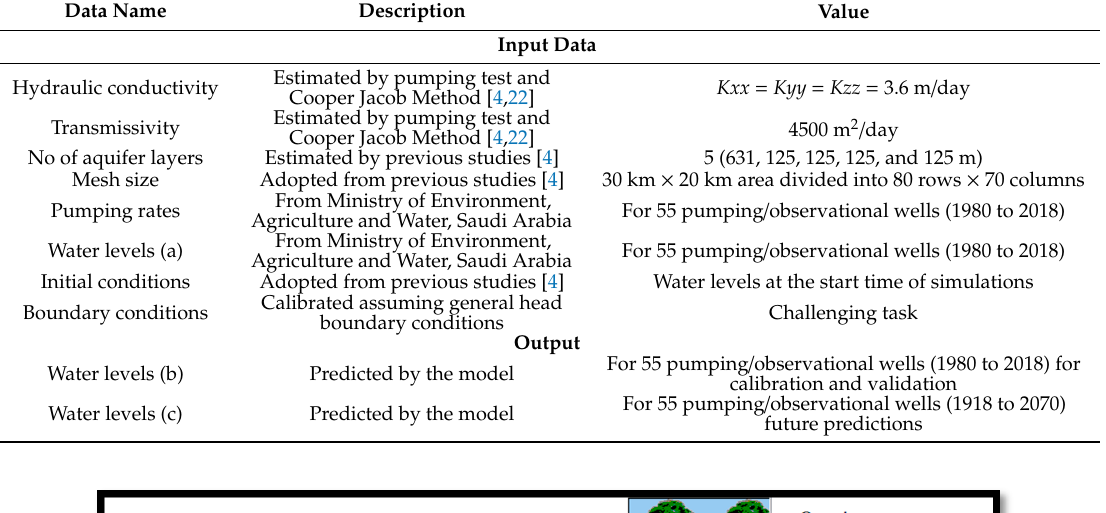
Table 2. Input and output data for MODFLOW.